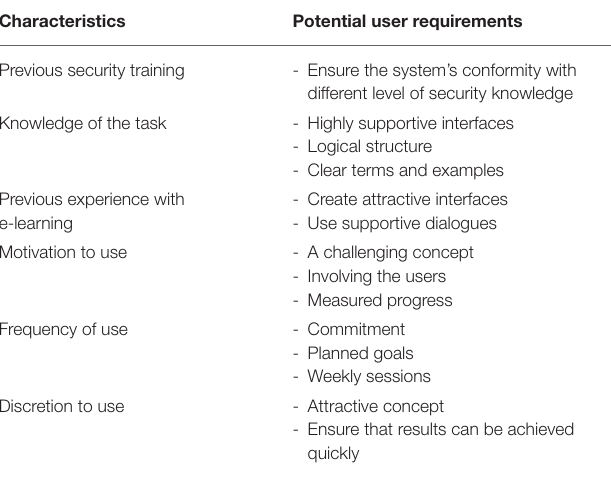
TABLE 1 | User’s characteristics and potential